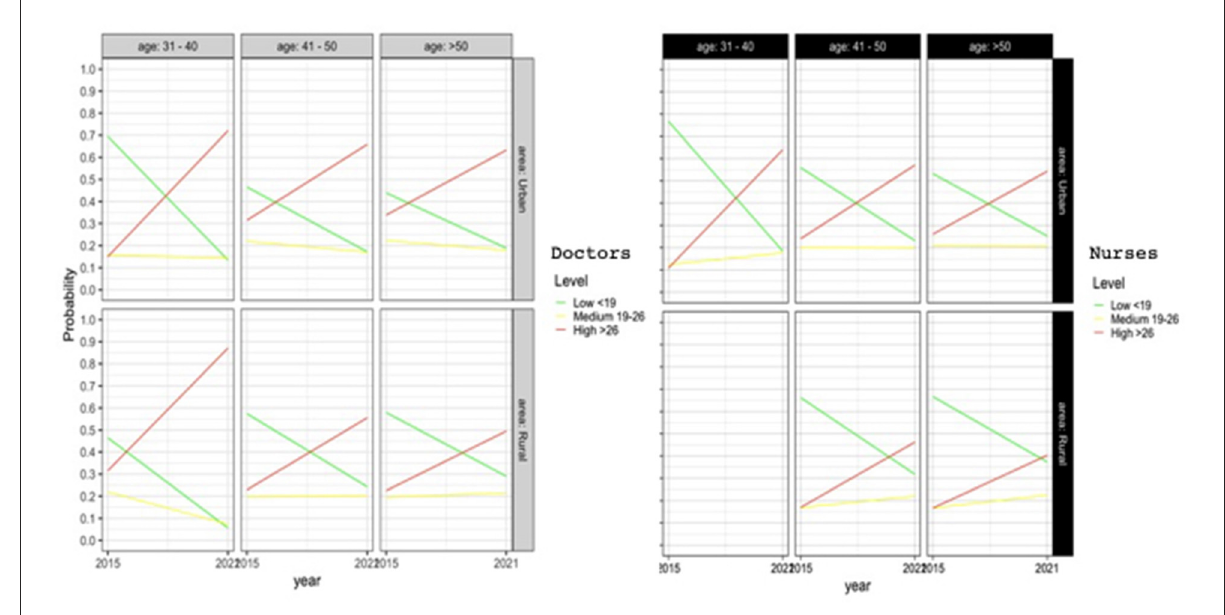
FIGURE1 Logistic regression model for emotional